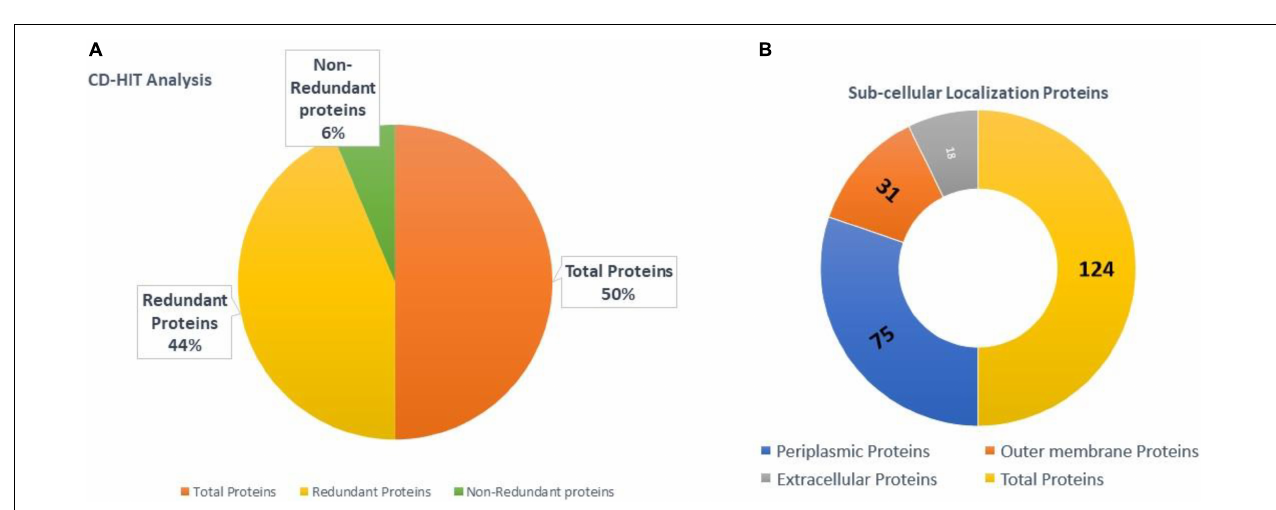
FIGURE 2 | The plot of the core pan of seven B. cepacia strains. The number of gene families in respective pathogen strain is also provided.